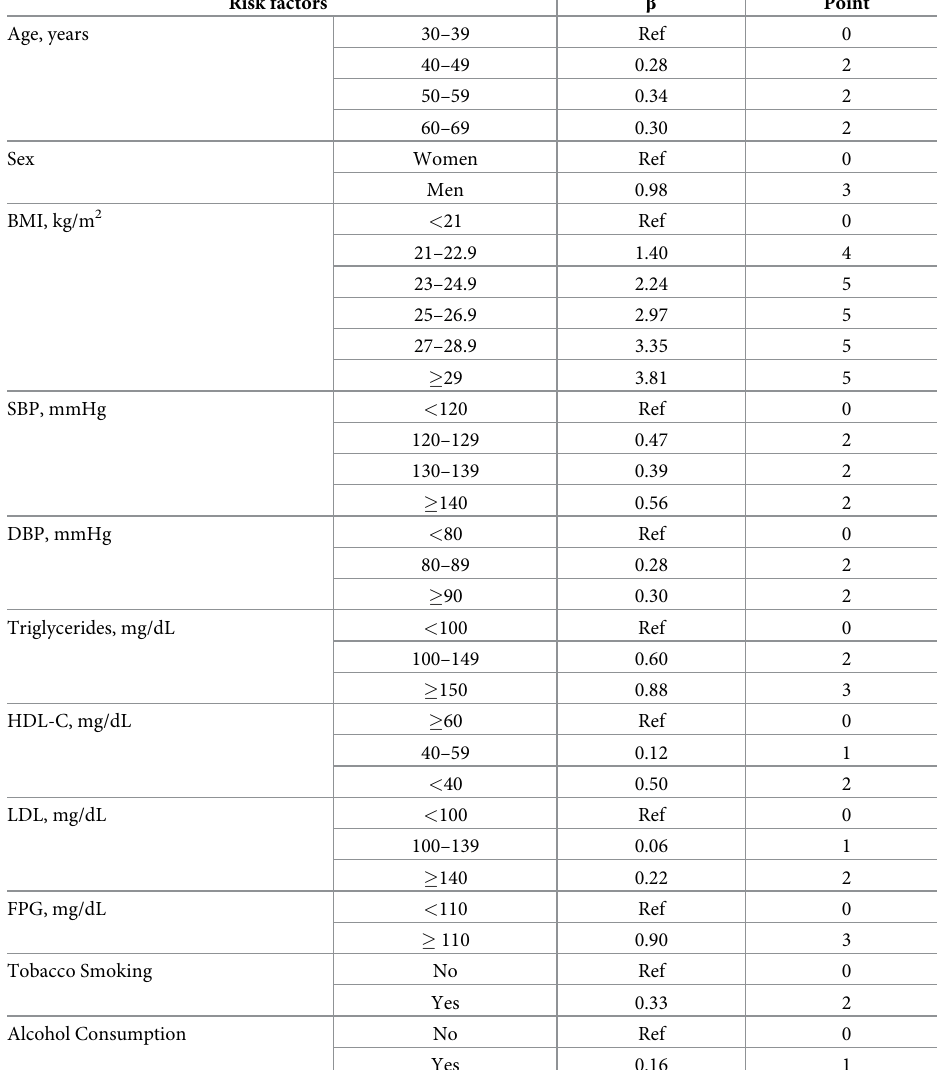
Table 3. Points assigned to risk factors in the primary risk score for predicting 5-year metabolic syndrome